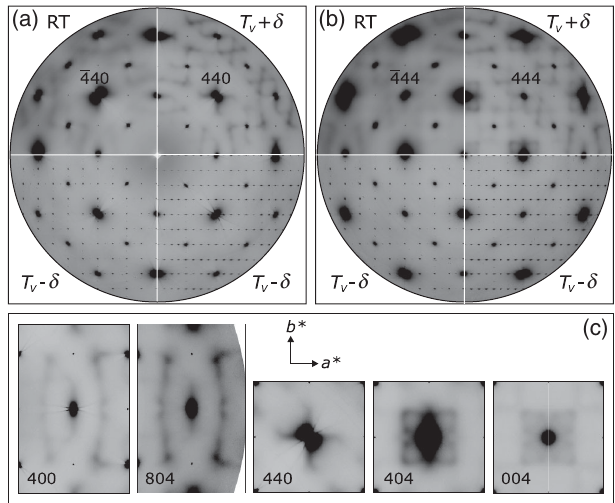
FIG. 2. Diffuse scattering in magnetite at variable temperature. Magnetite reciprocal space cuts HK0 (a) and HK4 (b) are shown þ δ ) and below at room temperature (RT), slightly above ( T V − δ ) the Verwey transition, with δ ∼ 2 . 5 K. Left-hand bottom ( T V panels: Sections perpendicular to the cell doubling direction. Right-hand bottom panels: Sections parallel to the cell doubling direction. Selected regions of interest (see text) are shown in (c) together with the unit cell vectors a (cid:1) and b (cid:1) . The room- temperature cut is scaled taking into account the thermal expansion for visualization purposes; the labels in (c) denote the central Bragg spot. Cubic m 3 m (above T ) and tetragonal V 4 =mmm (below T ) Laue symmetries are V